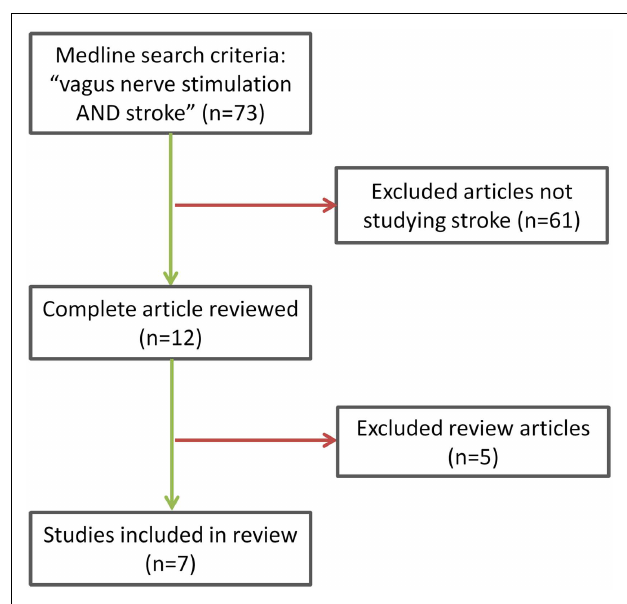
FIGURE 3 | Study inclusion criteria methodology